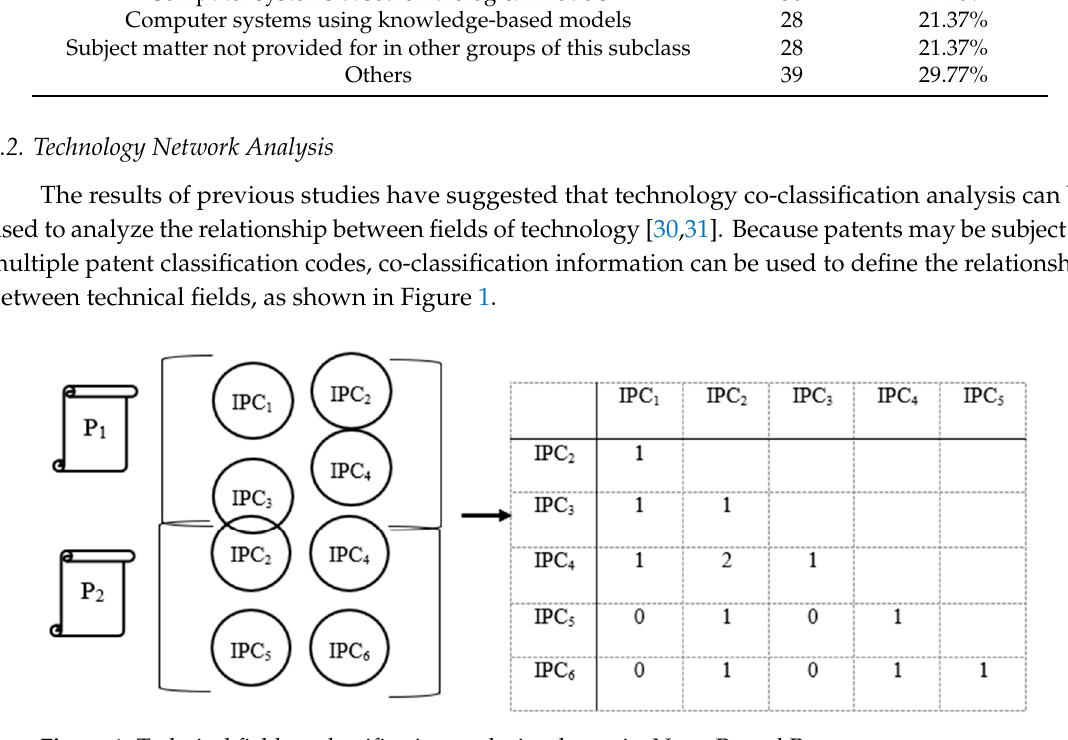
Figure 1. Technical field co-classification analysis schematic. Note: P 1 and P 2 represent two patents; IPC 1 , IPC 2 , IPC 3 ... IPC 6 represent six technical fields.